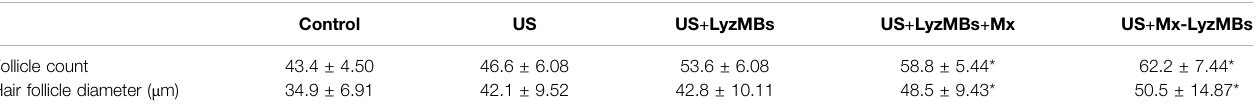
TABLE 4 | Results of histological analyses of the numbers of hair follicles and the diameters of the keratinized hair shafts after 21 days of treatment. The diameters of the keratinized hair shafts and the numbers of hair follicles were both greater in the US+LyzMBs+Mx and US+Mx-LyzMBs groups than in other three groups (* p <